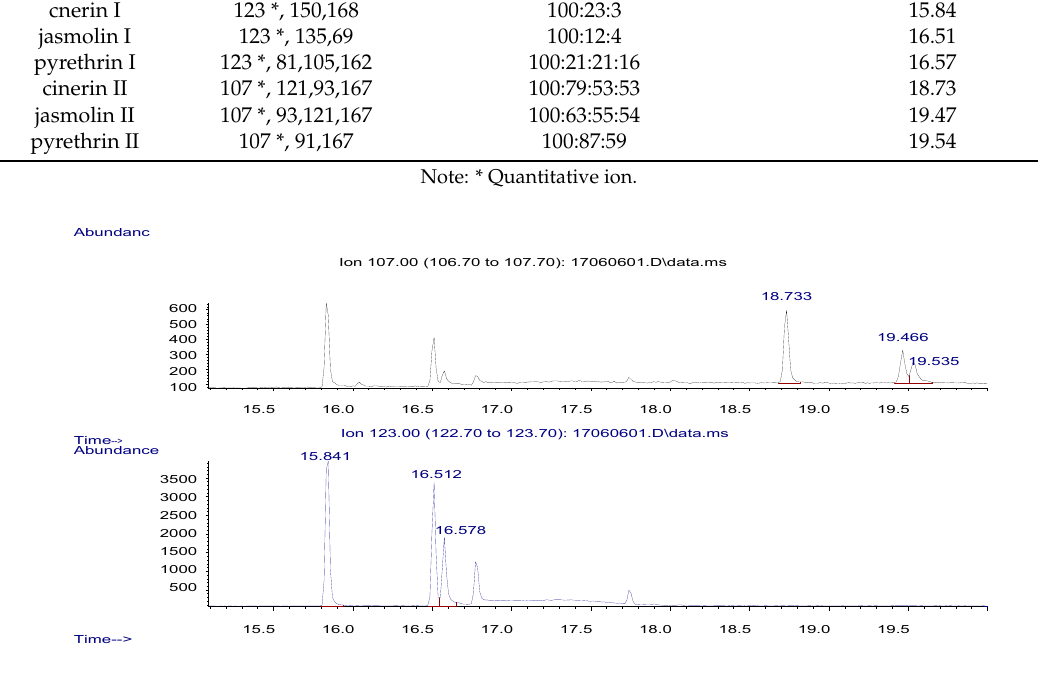
Table 2. Monitor ions with the relative abundances and the typical retention time of pyrethrins. Compounds